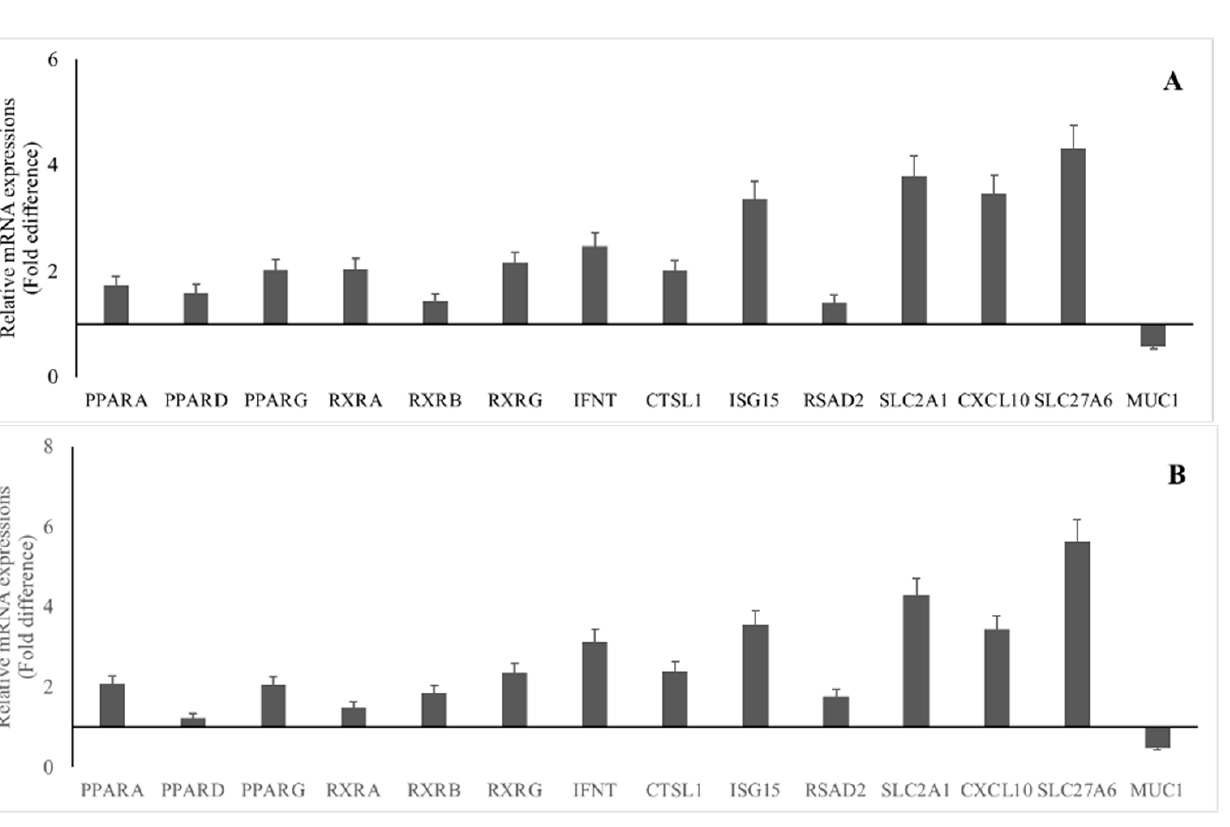
Figure 2. mRNA abundances in gestational day (GD) 16 embryo ( A ) and corresponding endometrium ( B ) of repeat breeder cows 1 with (*) or without subclinical endometritis 2 . * Reference group, relative mRNA expression is equal to one fold; all candidate genes were upregulated and MUC 1 was down regulated compared to reference group ( p < 0.05); 1 repeat breeder cows were with the history of failing to conceive after the first three inseminations post calving and with the history of at least one pregnancy loss between 30 and 60 days after any of the first three services during the second or third lactation; 2 cows with SCE, >6% PMN; cows without SCE, ≤ 6% PMN; PPAR —peroxisome